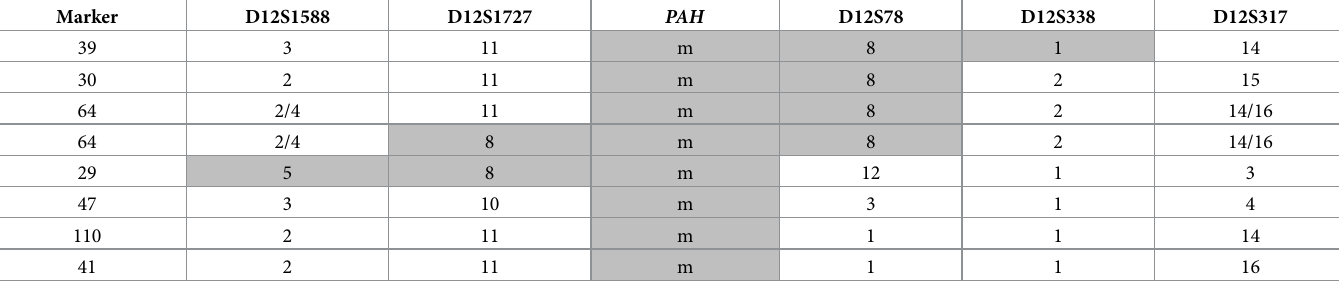
The saved fragments of the Karachay “founder haplotype” are highlighted by filling.